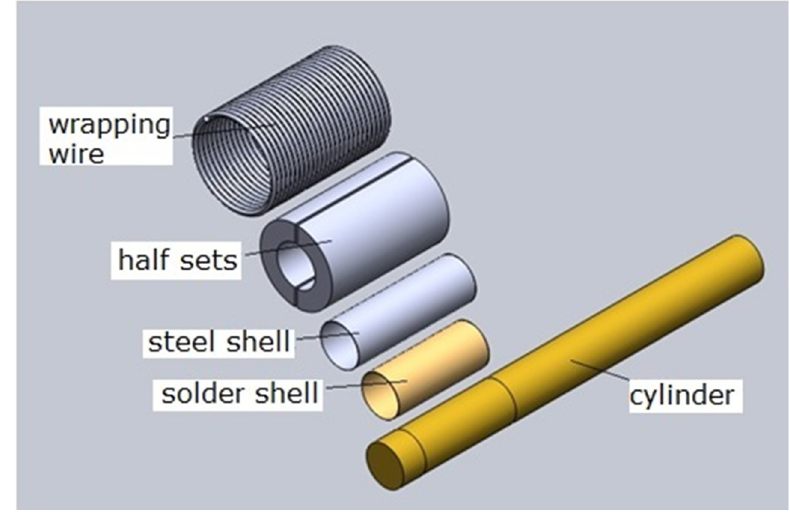
Figure 1. Schematic diagram of wrapping up the solder foil for sintering.